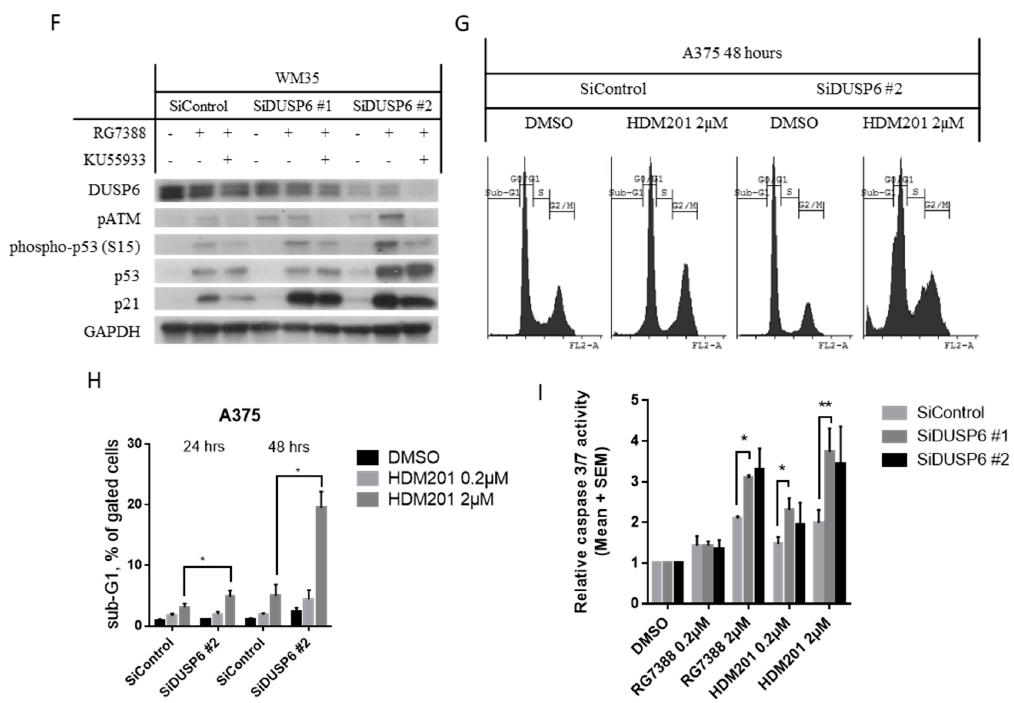
Figure 5. DUSP6 suppression by siRNA promotes the anticancer effect of MDM2 inhibitors through ATM-mediated p53 phosphorylation. ( A – D ) Growth inhibition of A375 ( A , B ) and WM35 ( C , D ) after 24-h treatment with siRNA against DUSP6 followed by 48-h RG7388 ( A , C ) or HDM201 ( B , D ) treatment. ( E ) Immunoblotting of WM35 after siRNA knockdown of DUSP6 for 24 h followed by treatment with 1 µ M HDM201 for 6 and 24 h. ( F ) Immunoblotting of WM35 after 24-h DUSP6 siRNA knockdown, followed by 200nM RG7388 ± 10 µ M KU55933 24-h treatment. ( G , H ) Flow cytometry of A375 treated with DUSP6 siRNA followed by HDM201 addition and presented as a histogram ( G ) and % of sub-G1 signals ( H ). ( I ) Caspase 3/7 assay of A375 after 24-h DUSP6 siRNA followed by RG7388 or